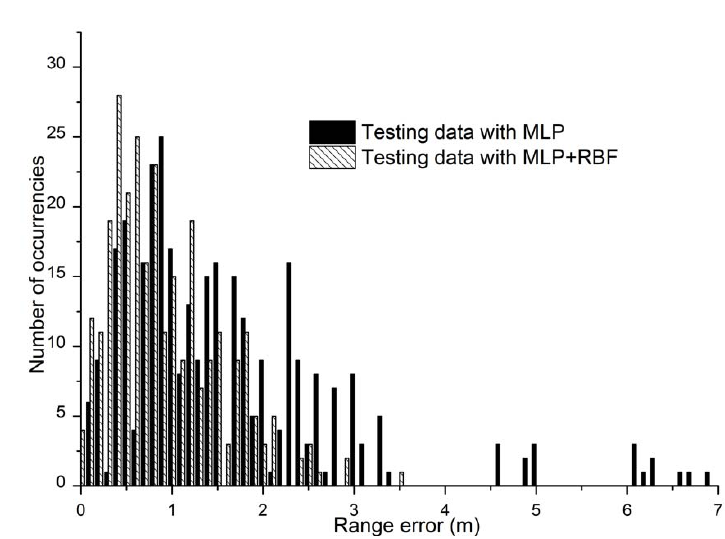
Figure 8. Comparison of distribution of errors between MLP and MLP + RBF.